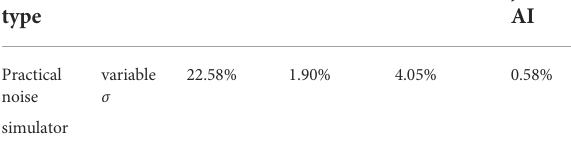
TABLE 5 The SSIM-based BD-rate of the proposed JICD compared to the Cheng model on noisy input